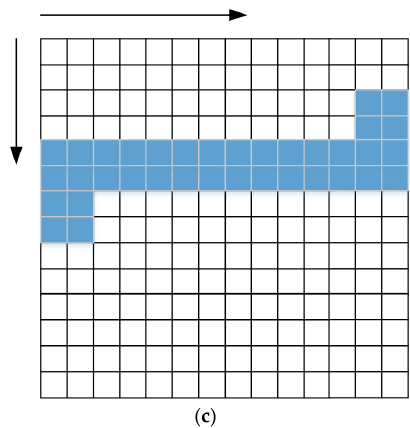
Figure 4. Schematic representation of the input sequence for the ConvNxN module.